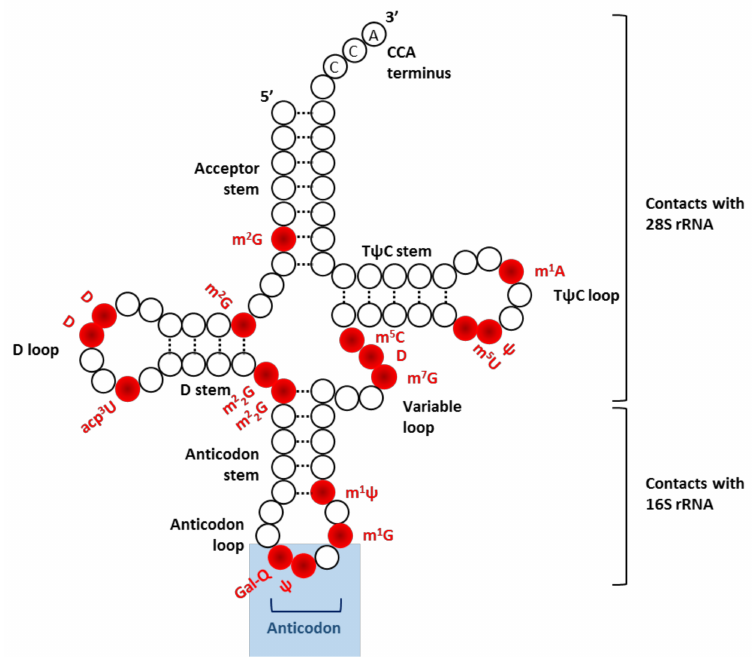
Figure 2. Illustration of secondary structure of tRNA. This cloverleaf shaped structure is due to four base-paired stems, three of them terminating with non-base-paired loops: D loop, anticodon loop, and T ψ C loop. Nucleotide modifications found in tRNA Tyr , one of the most modified tRNA, are annotated in red. Short names of individual modification are given according to the RNA modification databases